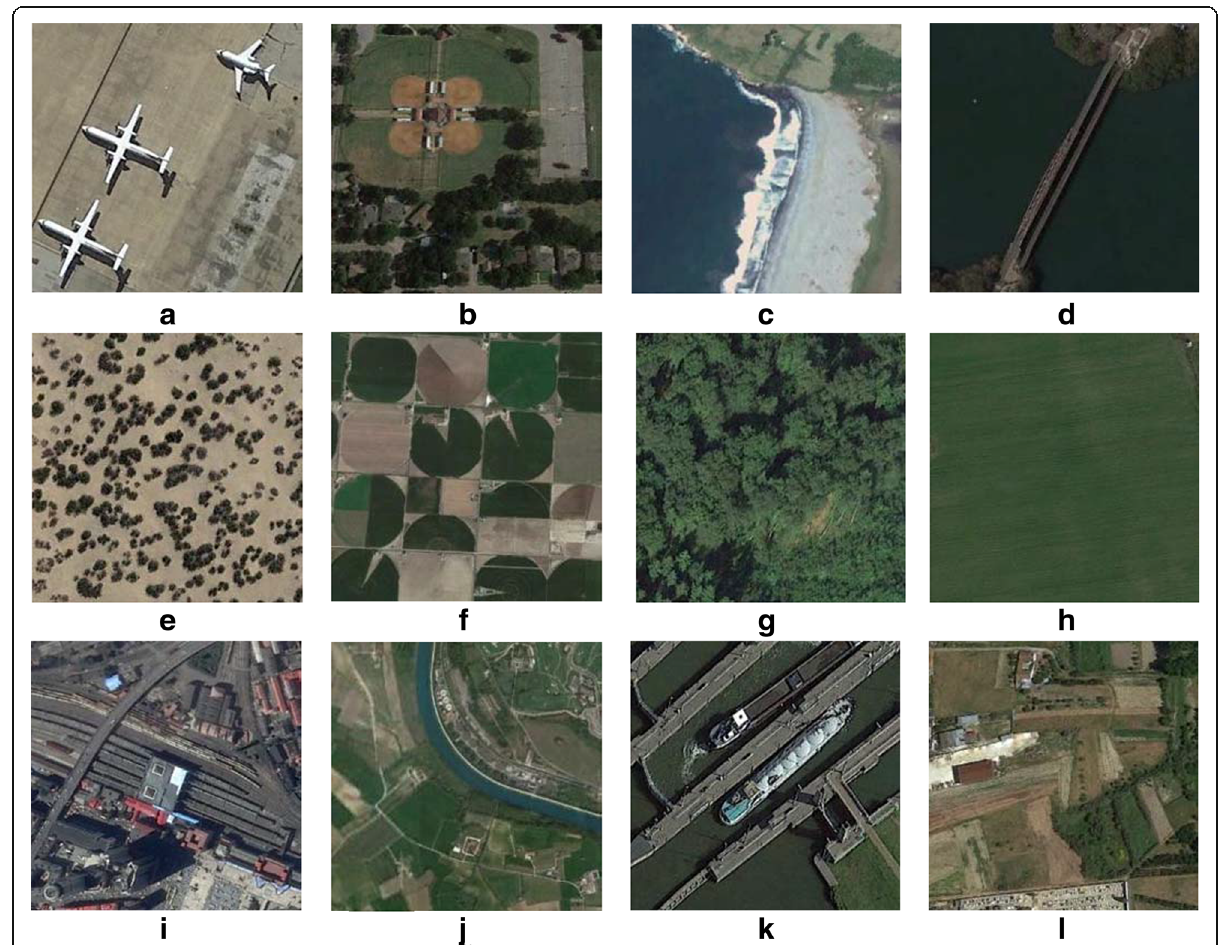
Fig. 5 Several scene images from the NWPU-RESISC45 dataset: a airplane, b baseball diamond, c beach, d bridge, e chaparral, f circular farmland, g forest, h meadow, i railway station, j river, k ship, l